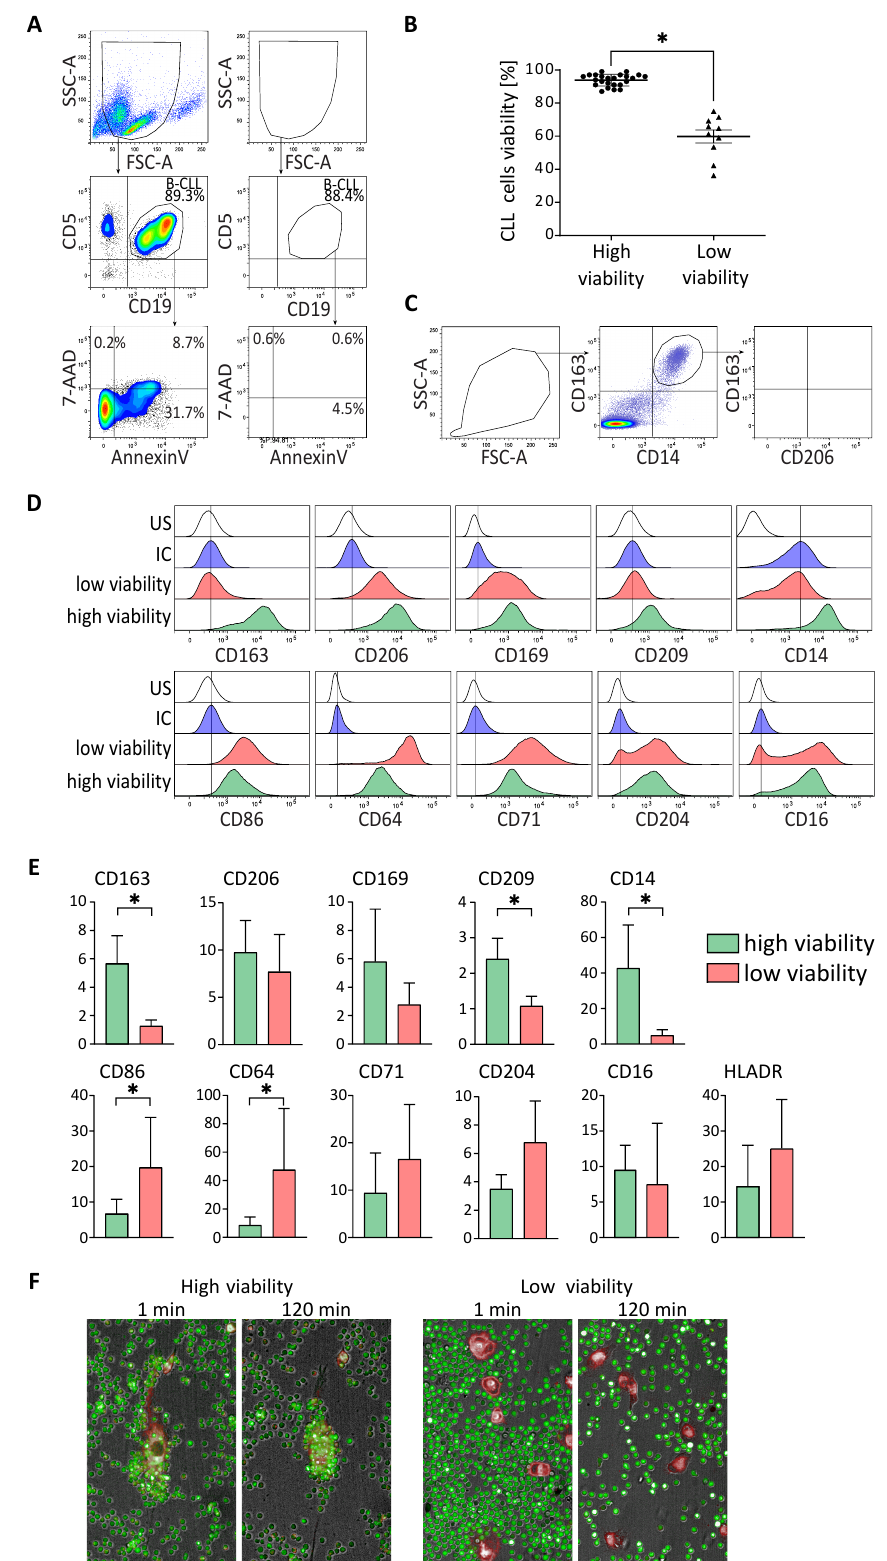
Figure 1. Non protective NLC for CLL cells harbour an M1-like phenotype. ( A , B ). Flow cytometry analysis of the percentage of viability (Annexin V/7-AAD negative cells) of CLL cells from cultures of PBMC from CLL patients after 14 days. (One representative experiment ( A ) and data for